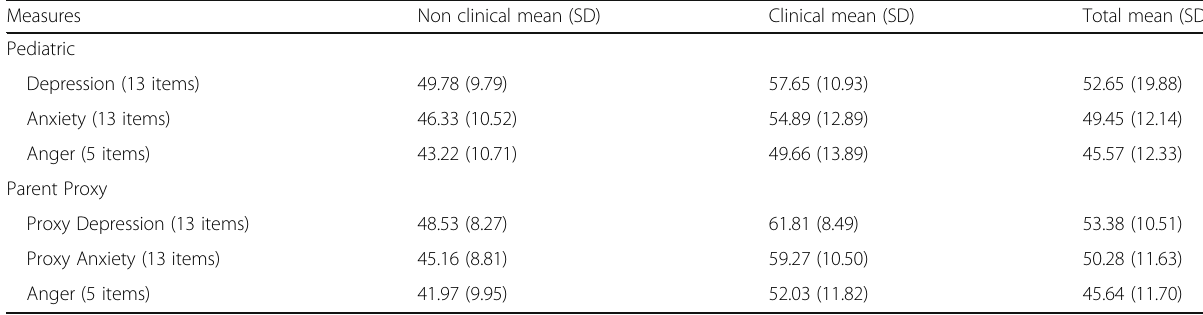
Table 2 Descriptive statistics for PROMIS measures